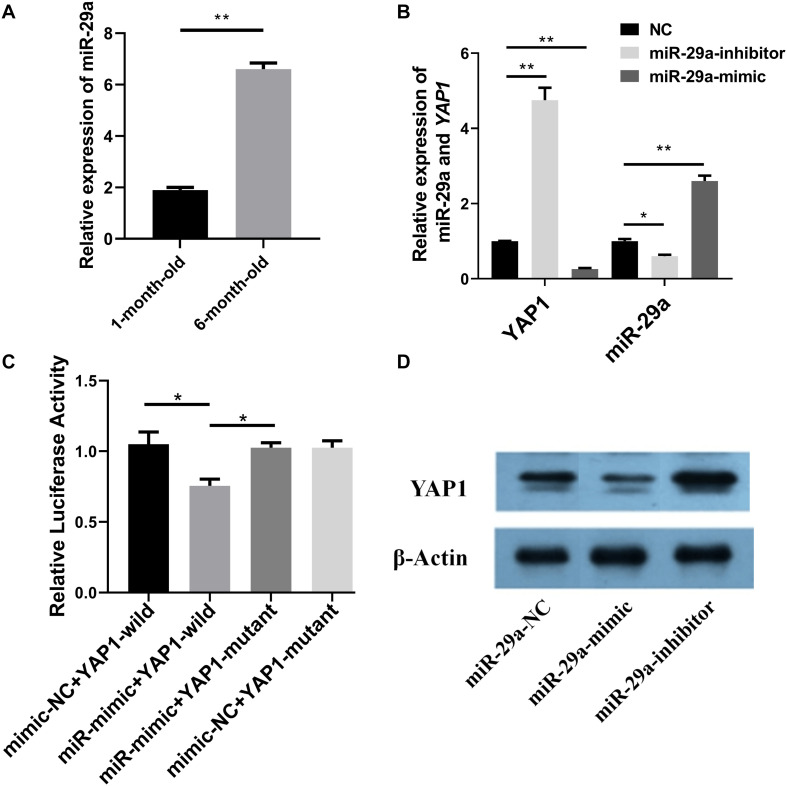
Interaction between miR-29a and YAP1. (A) The expression of miR-29a in the longissimus dorsi muscle between 1-month-old and 6-month-old Hu sheep. (B) The relative expression level of miR-29a and YAP1 after miR-29a mimic or inhibitor was transfected into SMSCs. (C) Results of the dual-luciferase reporter assay to confirm the potential interaction between miR-29a and YAP1, after YAP1-wild or YAP1-mutant, recombined dual-luciferase reporter plasmid, and miR-29a mimic (and mimic-NC) or miR-29a inhibitor (and inhibitor-NC) were co-transfected into HEK293T cells. (D) The expression of YAP1 and β-actin was detected by western blot after miR-29a mimic and inhibitor were transfected into SMSCs. *P < 0.05 or **P < 0.01.